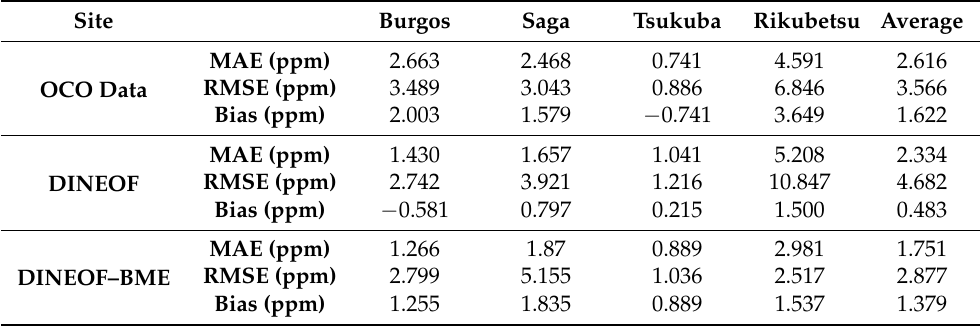
Table 2. Results of the TCCON XCO 2 Measured Data Compared with the OCO XCO 2 Data and the Product of XCO 2 interpolated by DINEOF Method the Product of XCO 2 interpolated by the synthetic DINEOF–BME